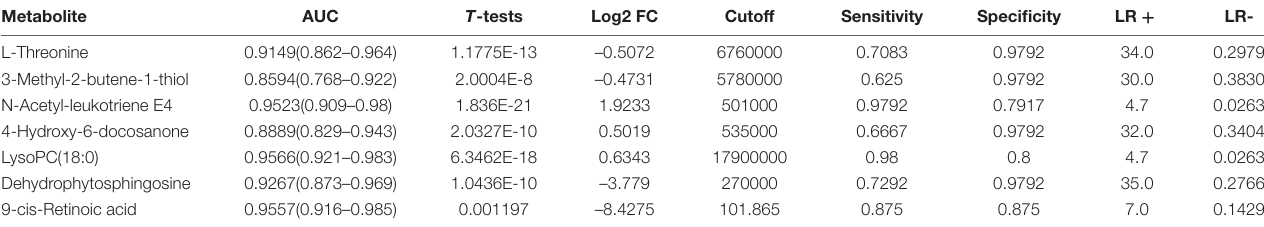
TABLE 3 | Receiver operating characteristic (ROC) curve analysis for individual